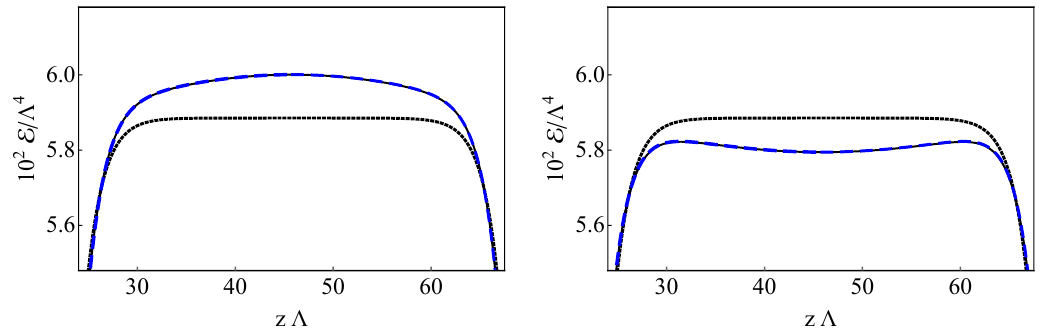
Figure 26 . The solid black curves show snapshots of (cid:12)gure 4(left) at times t (cid:3) = 5490 (left) and t (cid:3) = 5740 (right). In each case the dashed blue curve is the result of using expression (3.9). For comparison, the black dotted line shows the (cid:12)nal static pro(cid:12)le at asymptotically late times.